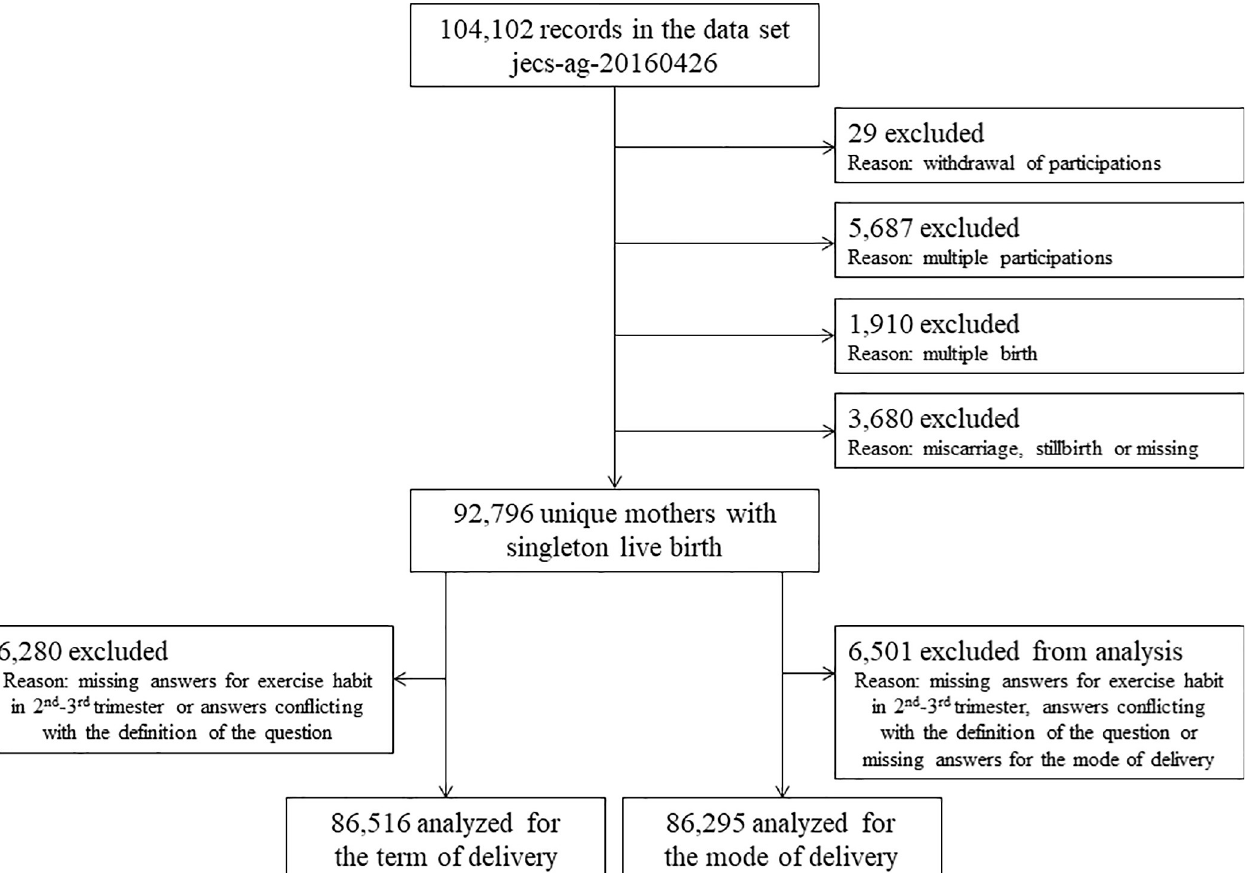
Fig 1. Participants inclusion flowchart with regard to the analysis of physical activities during pregnancy. The study included 92,796 pregnant women from the dates of Japan Environment and Children’s Study (JECS).